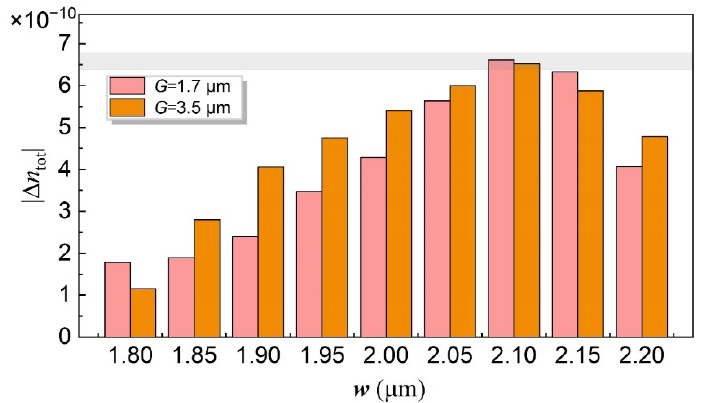
Figure 4. The maximum refractive index change of the optical waveguide | Δ𝑛 tot | as a function of the waveguide width w for gap width G = 1.7 μ m and G = 3.5 μ m.